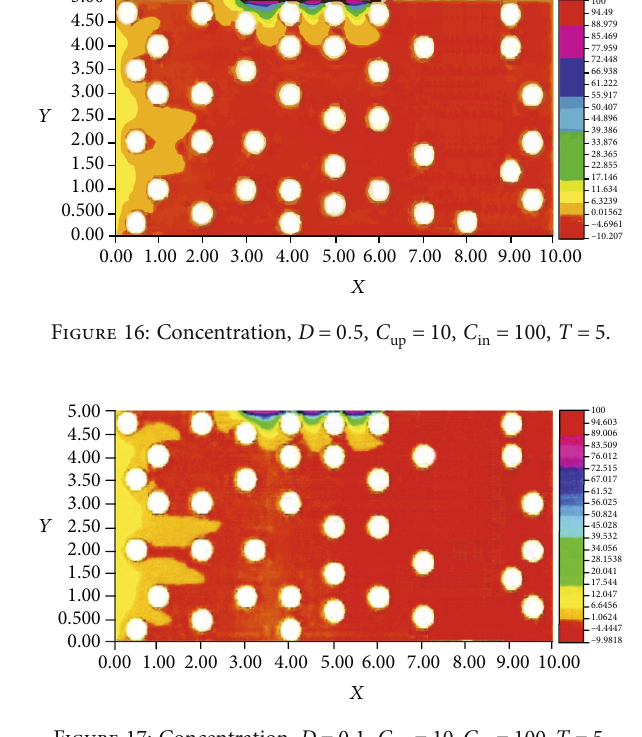
= 10, C = 100, T = 5 up in